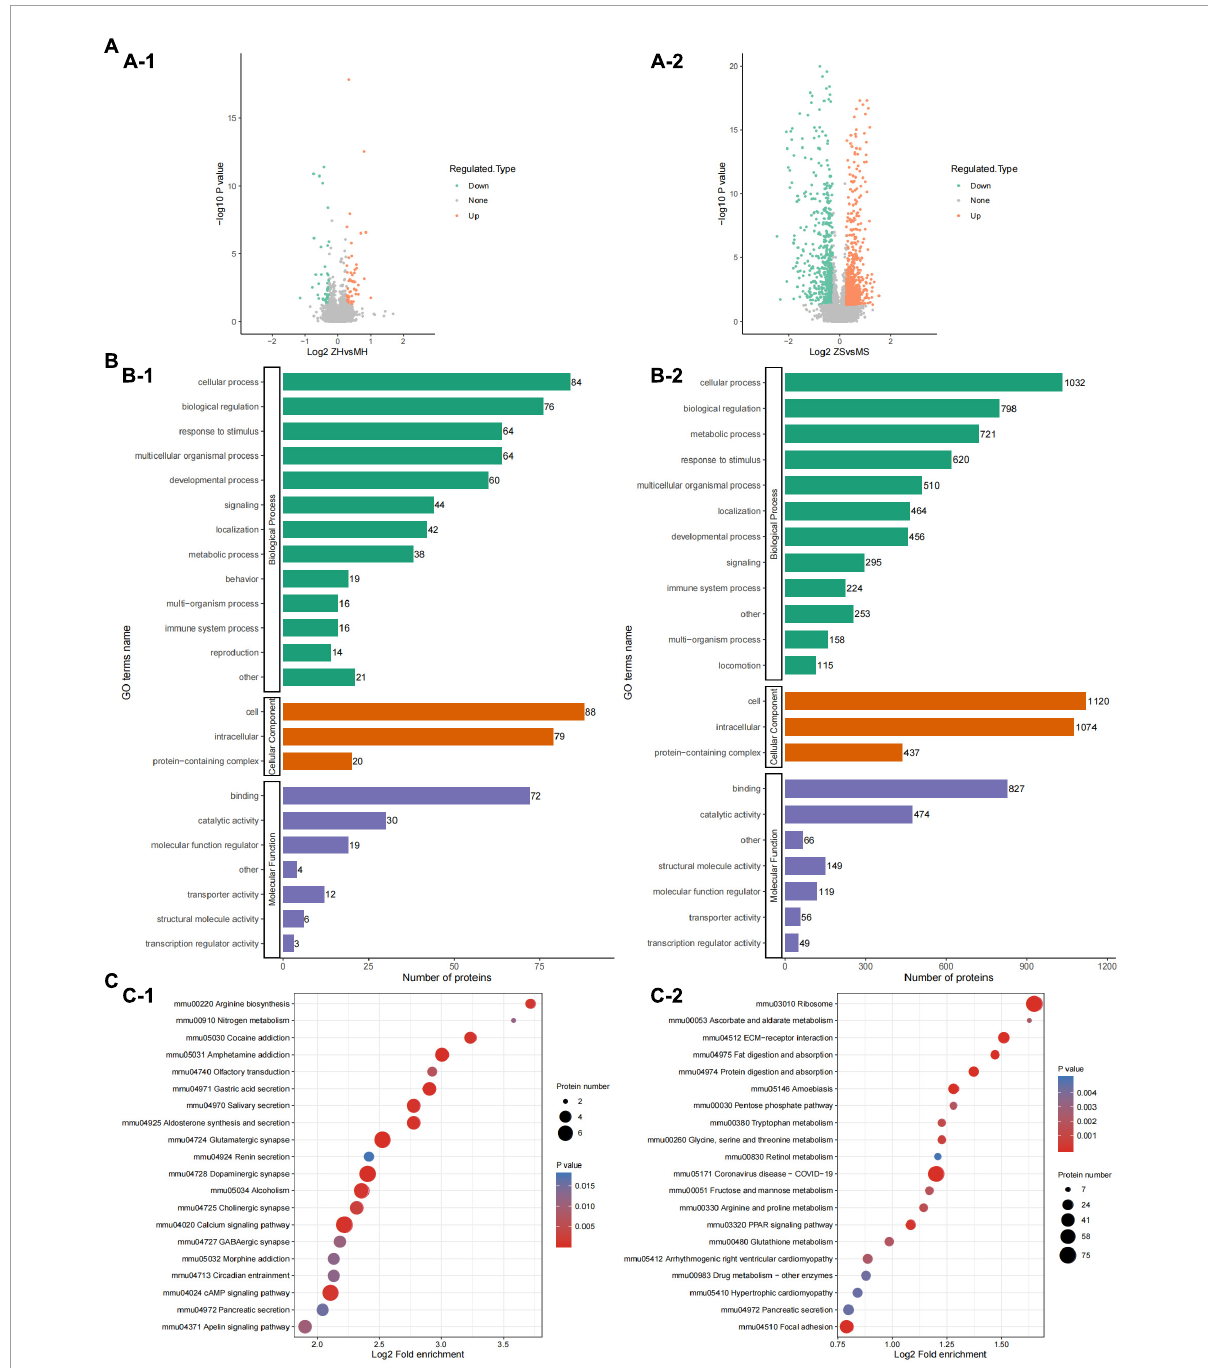
FIGURE8 The results of TMT labeling studies. (A) Volcano plot of differential proteins between the PD and PWP groups. (A-1) Differential proteins in substantia nigra tissue. (A-2) Differential proteins in duodenal tissue. (B) Bar plot of GO terms of the PD and PWP groups. (B-1) The result were enriched in substantia nigra tissue. (B-2) The result were enriched in duodenal tissue. (C) Bar plot showing the result of KEGG pathways between the PD and PWP groups. (C-1) KEGG pathways in substantia nigra tissue. (C-2) KEGG pathways in duodenal